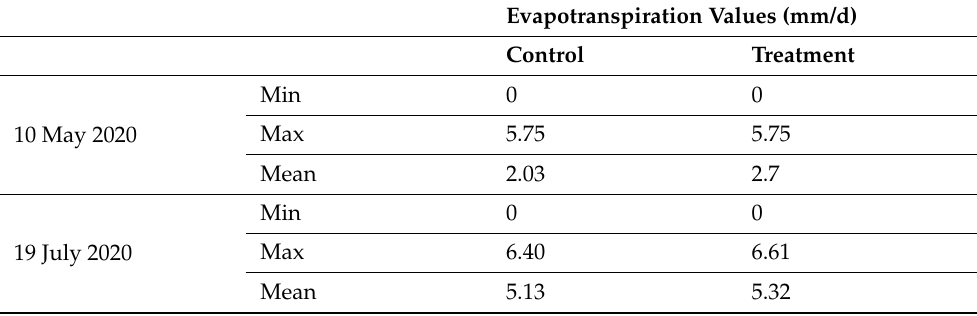
Table 8. Descriptive statistics for estimated evapotranspiration values for sUAS flights 10 May